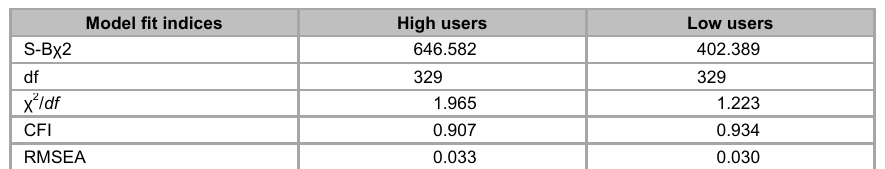
Model fit of measurement